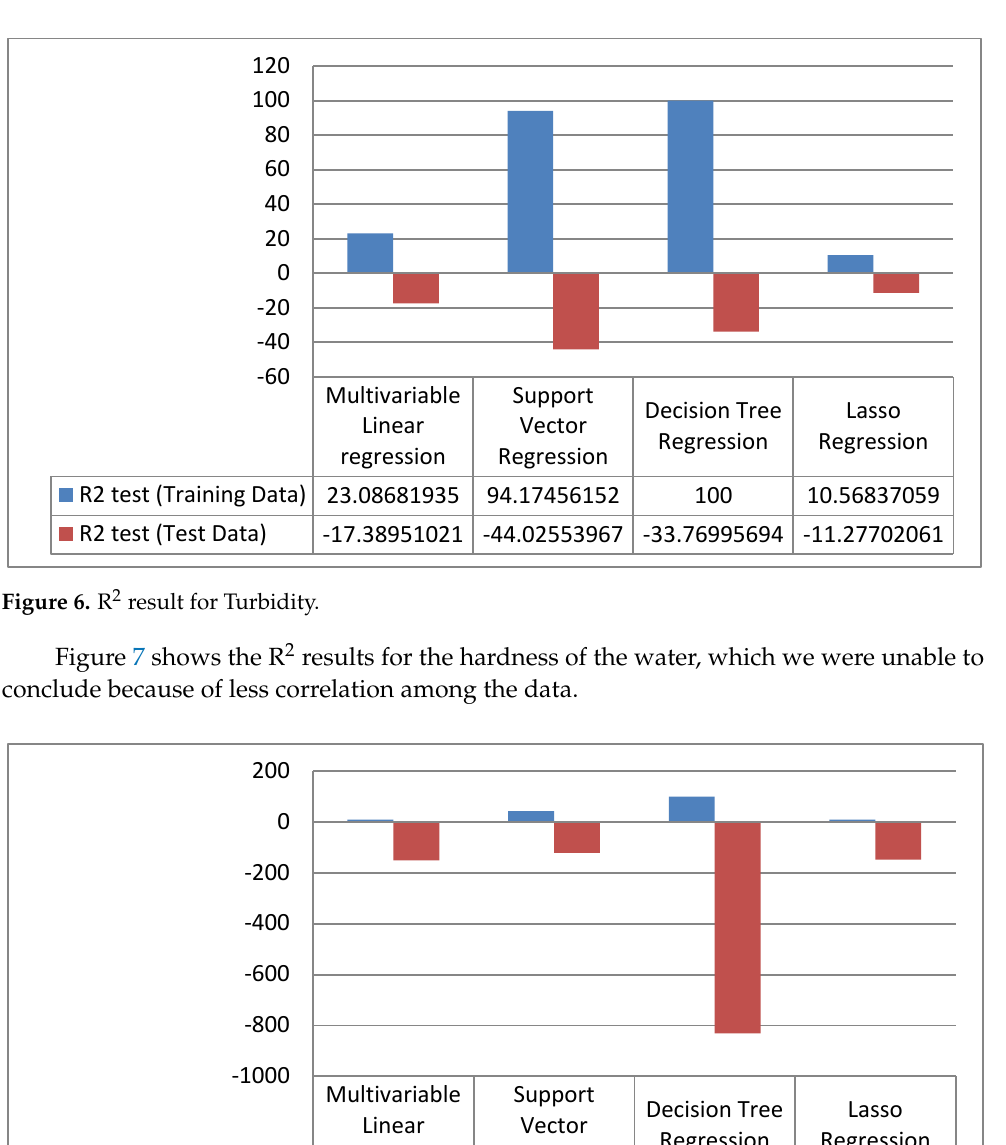
Figure 5. R 2 result for pH.